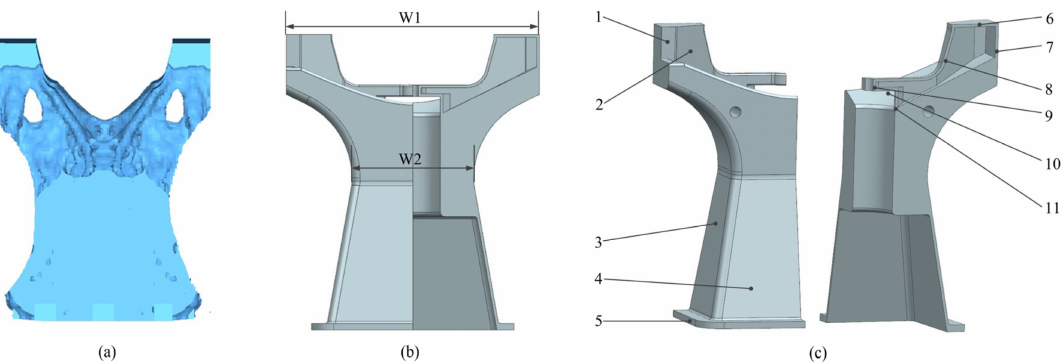
Figure 3. Optimized structural configuration of the vertical bracket. ( a ) Topology optimization structural configuration. ( b ) Bionic optimization structural configuration. ( c ) Size optimization structural